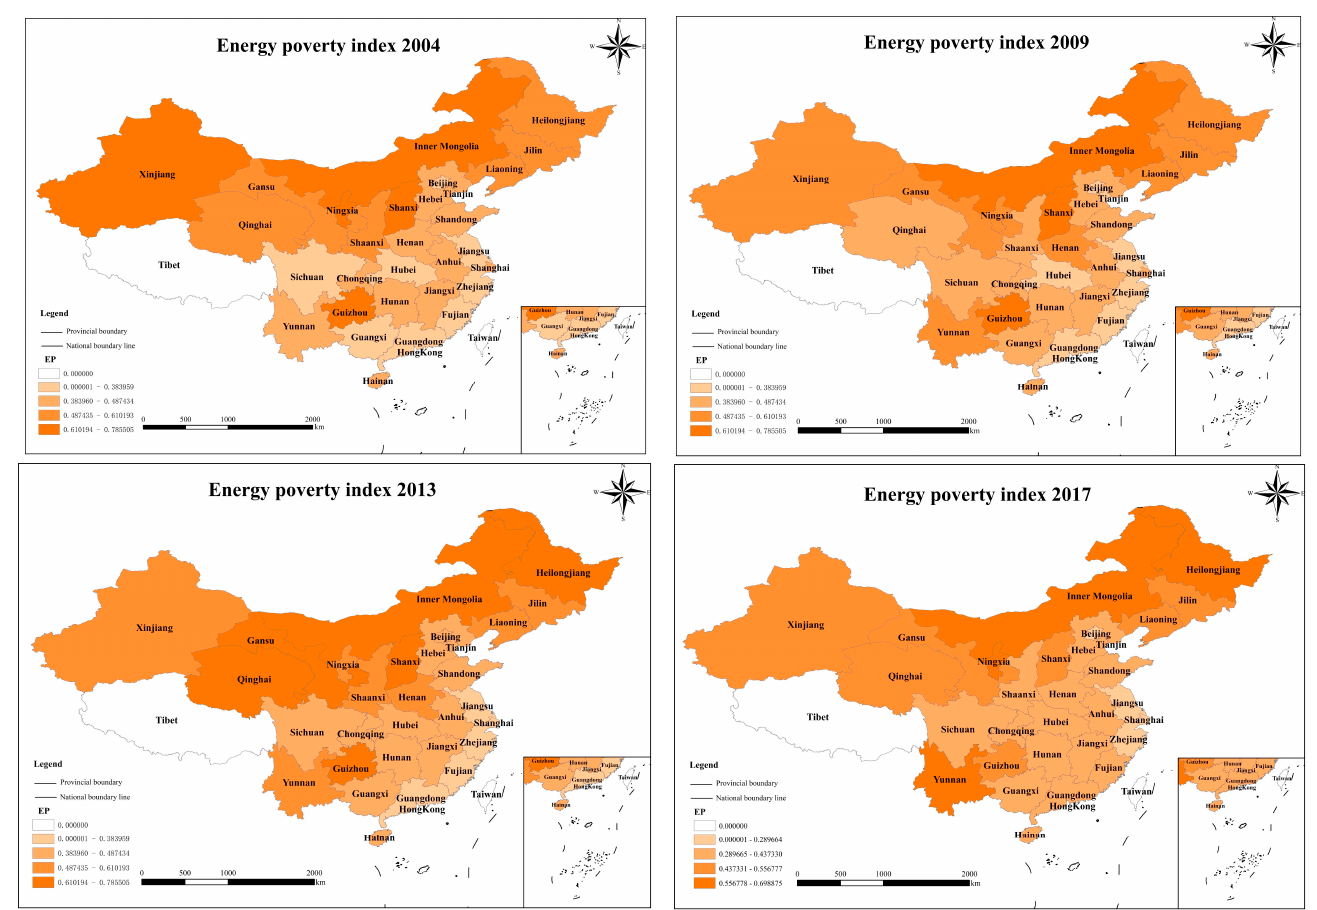
Figure 1. Spatial distribution of energy